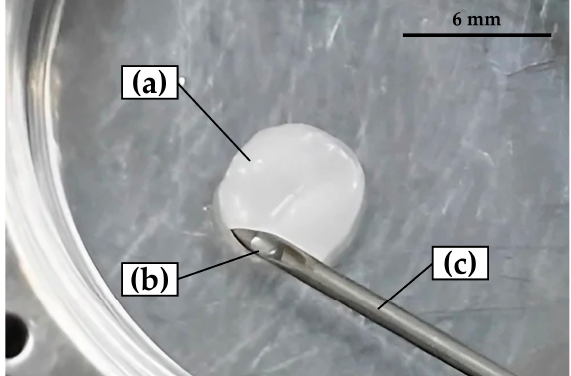
Figure 14. The photo of a cHLA/cAG disk on a 35 mm culture dish after pouring the aliquot with nHAp and BMP using a syringe. Note: ( a ) wet cHLA/cAG/nHAp/BMP construct, ( b ) residual aliquot, and ( c ) syringe used.